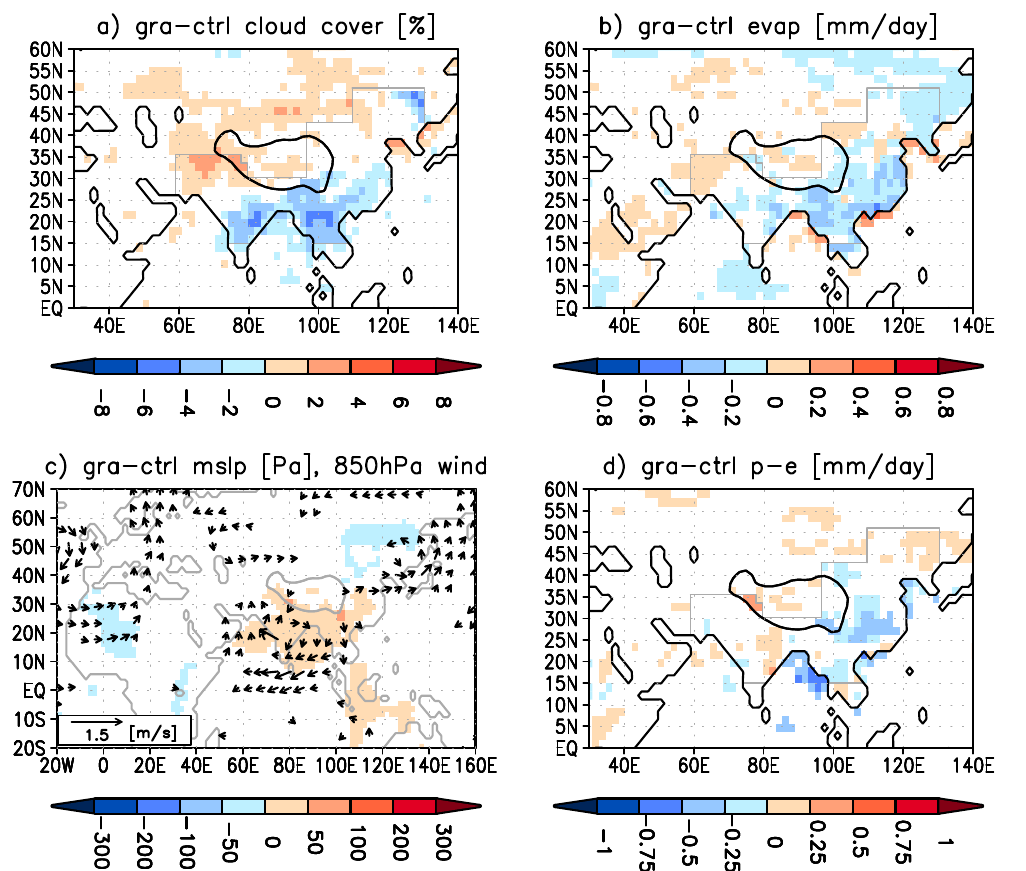
Fig. 8. Same as Fig. 7, but for the dry/cold season. Limit for wind-magnitude to be shown: 0.15ms − 1